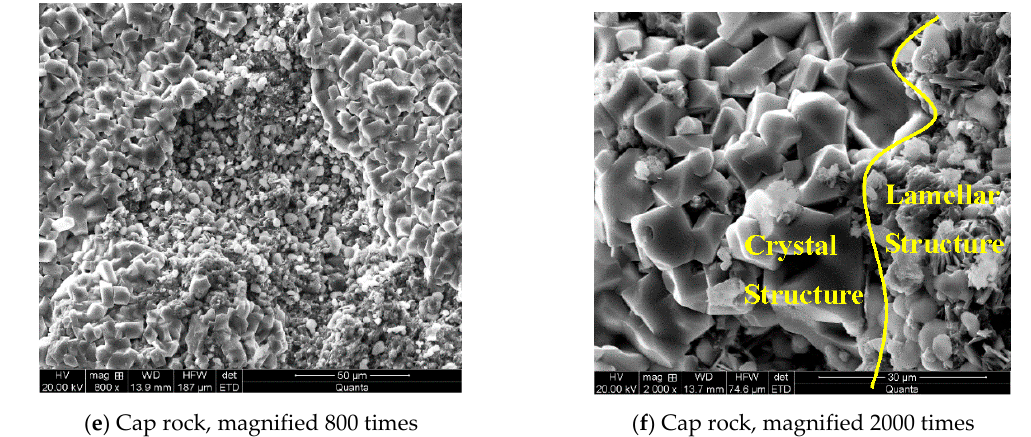
Figure 3. Electron microscope scans of the rock surrounding the strategic petroleum reserve (SPR) salt cavern.